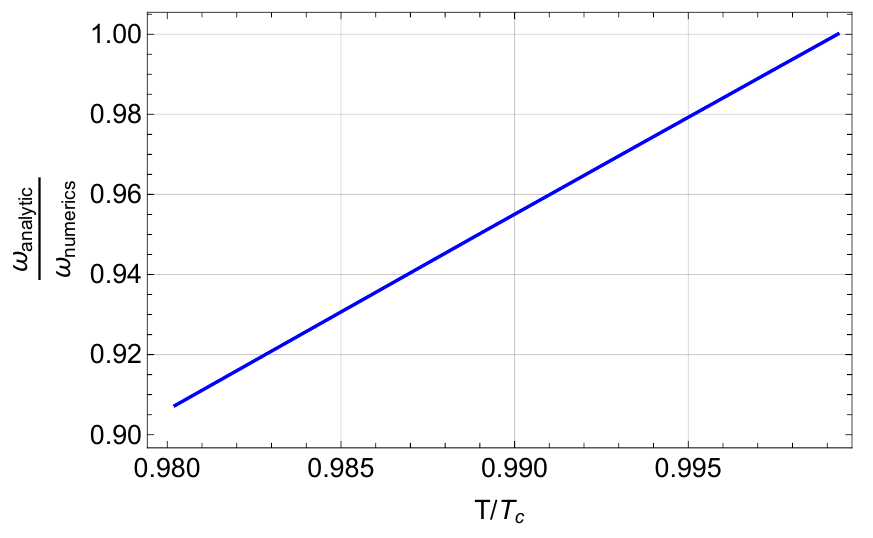
Figure 1 . Plot of the ratio of the analytic result for the gap coming from 3.39 and the gap computed numerically through the calculation of quasinormal modes as a function of T/T c . We see good quantitative agreement close to the critical temperature. Here φ s = 1 , µ = 1 , ζ ρ = 1 , ζ φ = 0 , λ ρ = 1 , λ φ = 1 and λ = − 1